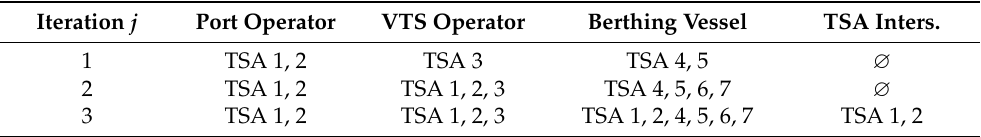
Table 1. Familiar TSAs from each participant for each negotiation iteration j and common TSA intersection according to the Negotiation